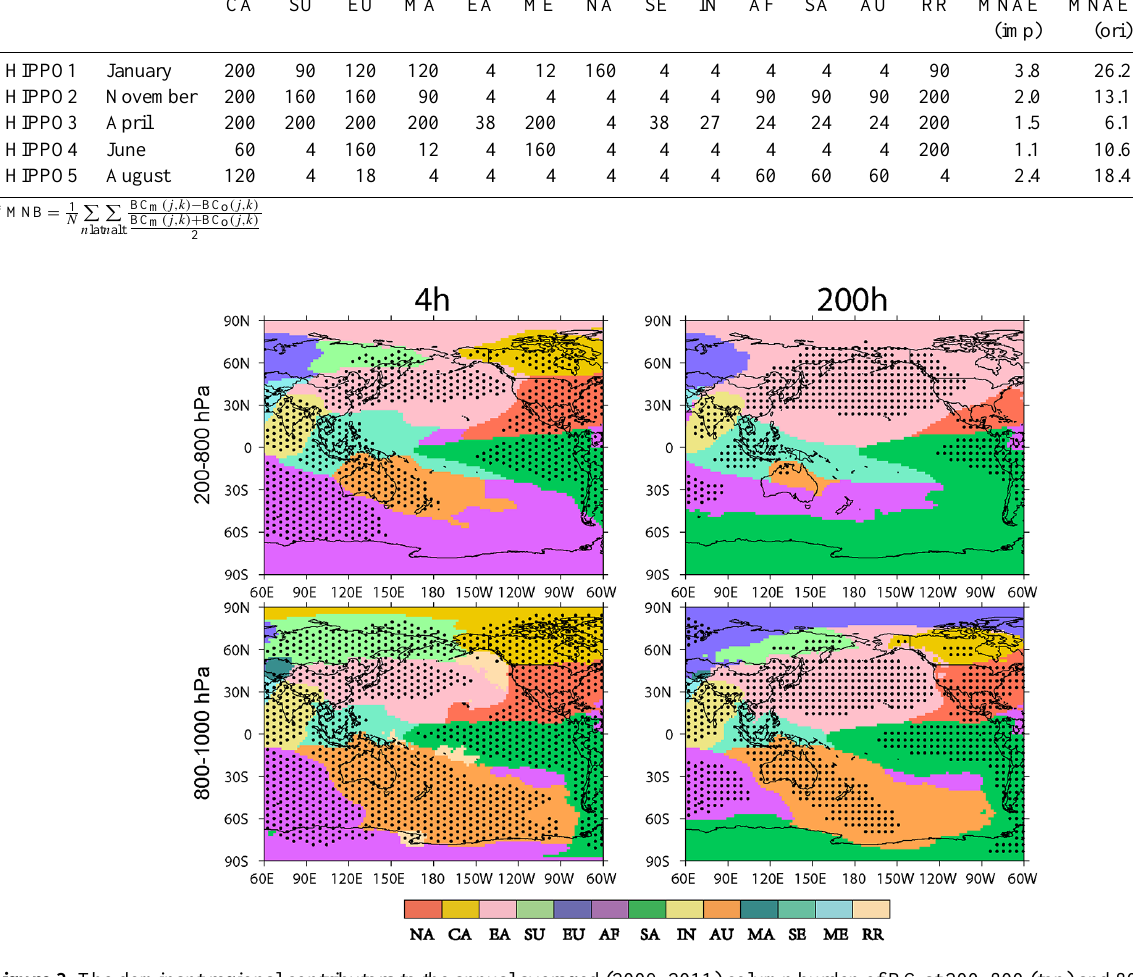
Figure 3. The dominant regional contributors to the annual averaged (2009–2011) column burden of BC at 200–800 (top) and 800–1000hPa (bottom) when aging timescale is 4 (left) and 200h (right). Dotted areas are where the dominant contributors account for more than 50% of the total BC